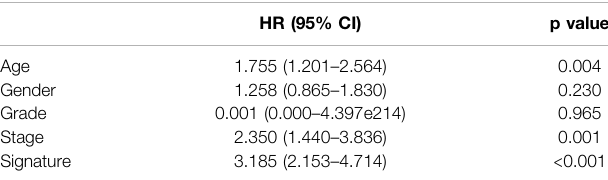
TABLE 1 | Multivariate COX analysis of clinical parameters and prognostic